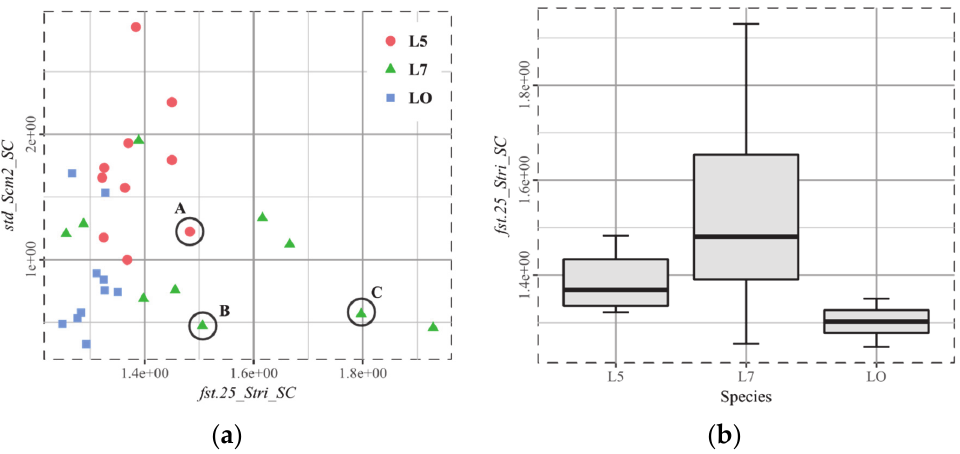
Figure 13. Ewes fed on mature grass and red clover+barley kernels, most discriminating parameters. ( a ) The anisotropy parameter Stri and the topology parameter Scm2 separate L5, L7, LO. The surfaces related to the points (A) and (B) are represented in the ESM; and, ( b ) fst.25_Stri_SC is statistically lower for LO than for L5 and L7.